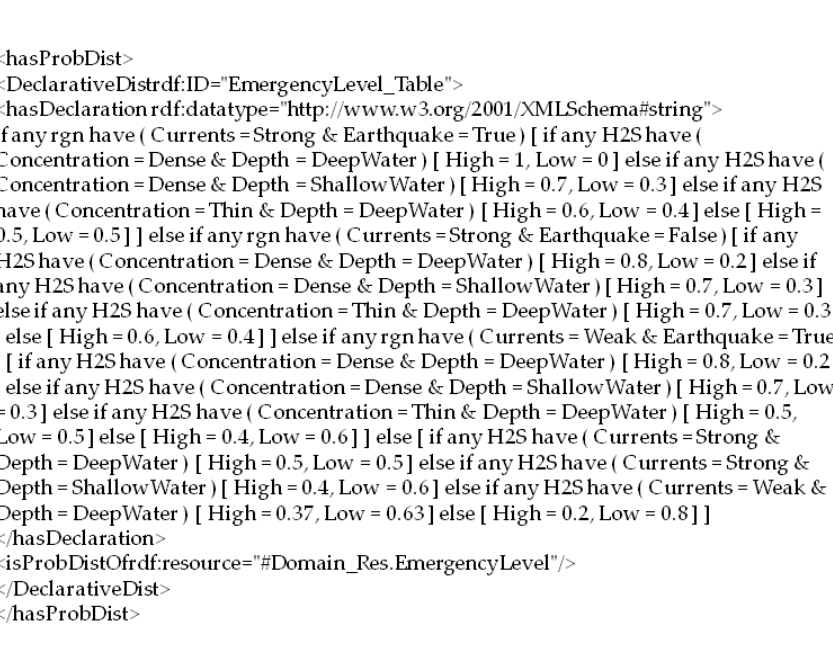
Figure 13. The MEBN reasoning for the emergency level.